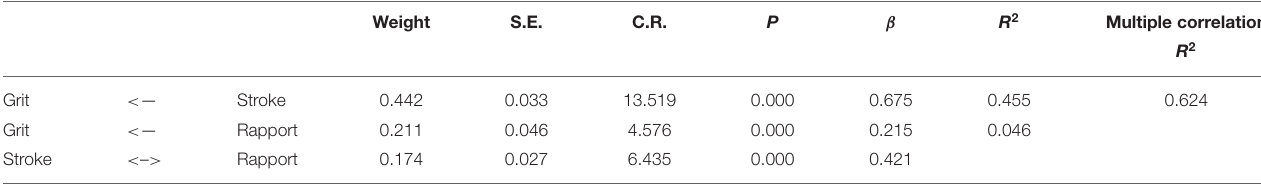
TABLE 5 | Results of multiple linear regression analysis with